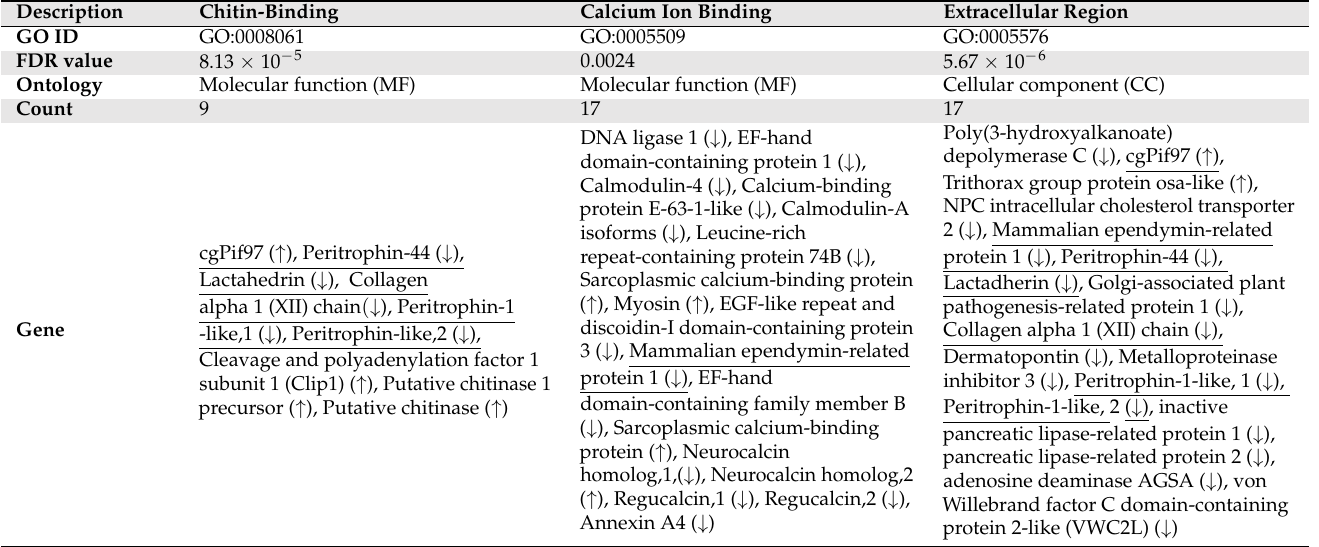
Table 4. Gene Ontology analysis of transcripts with differential expression in Pedi and PL batches before and after conspecific cue settlement induction. Underlined gene transcripts are those found in two GO